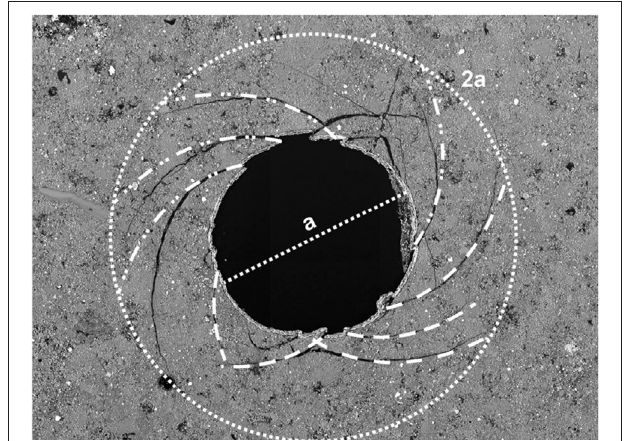
FIGURE 1 | Shear localization pattern in the form of logarithmic spirals observed in hole enlargement experiments on black shale (Meier et al.,